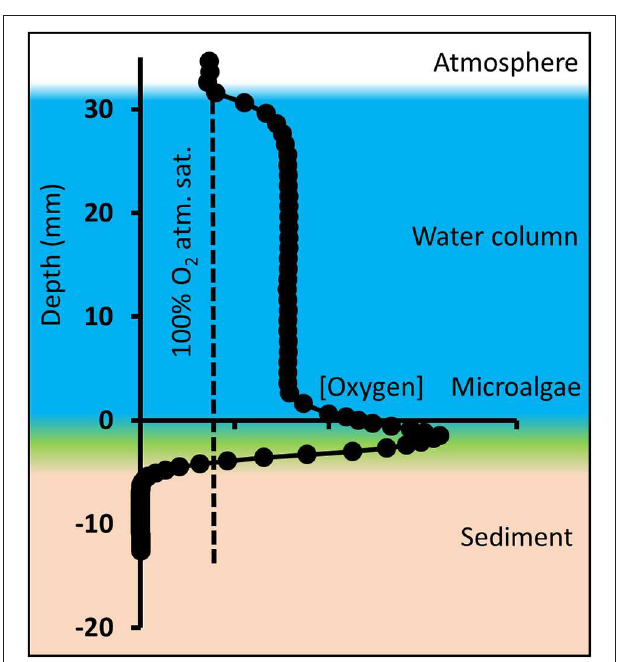
FIGURE 3 | Schematic overview of oxygen microprofiles in shallow tidal ponds, here exemplified with an oxygen profile measured in the afternoon. Microprofiling was conducted from the atmosphere through the water column and layer of benthic microalgae into the sediment. Depth “zero” is defined as the top of the microalgal